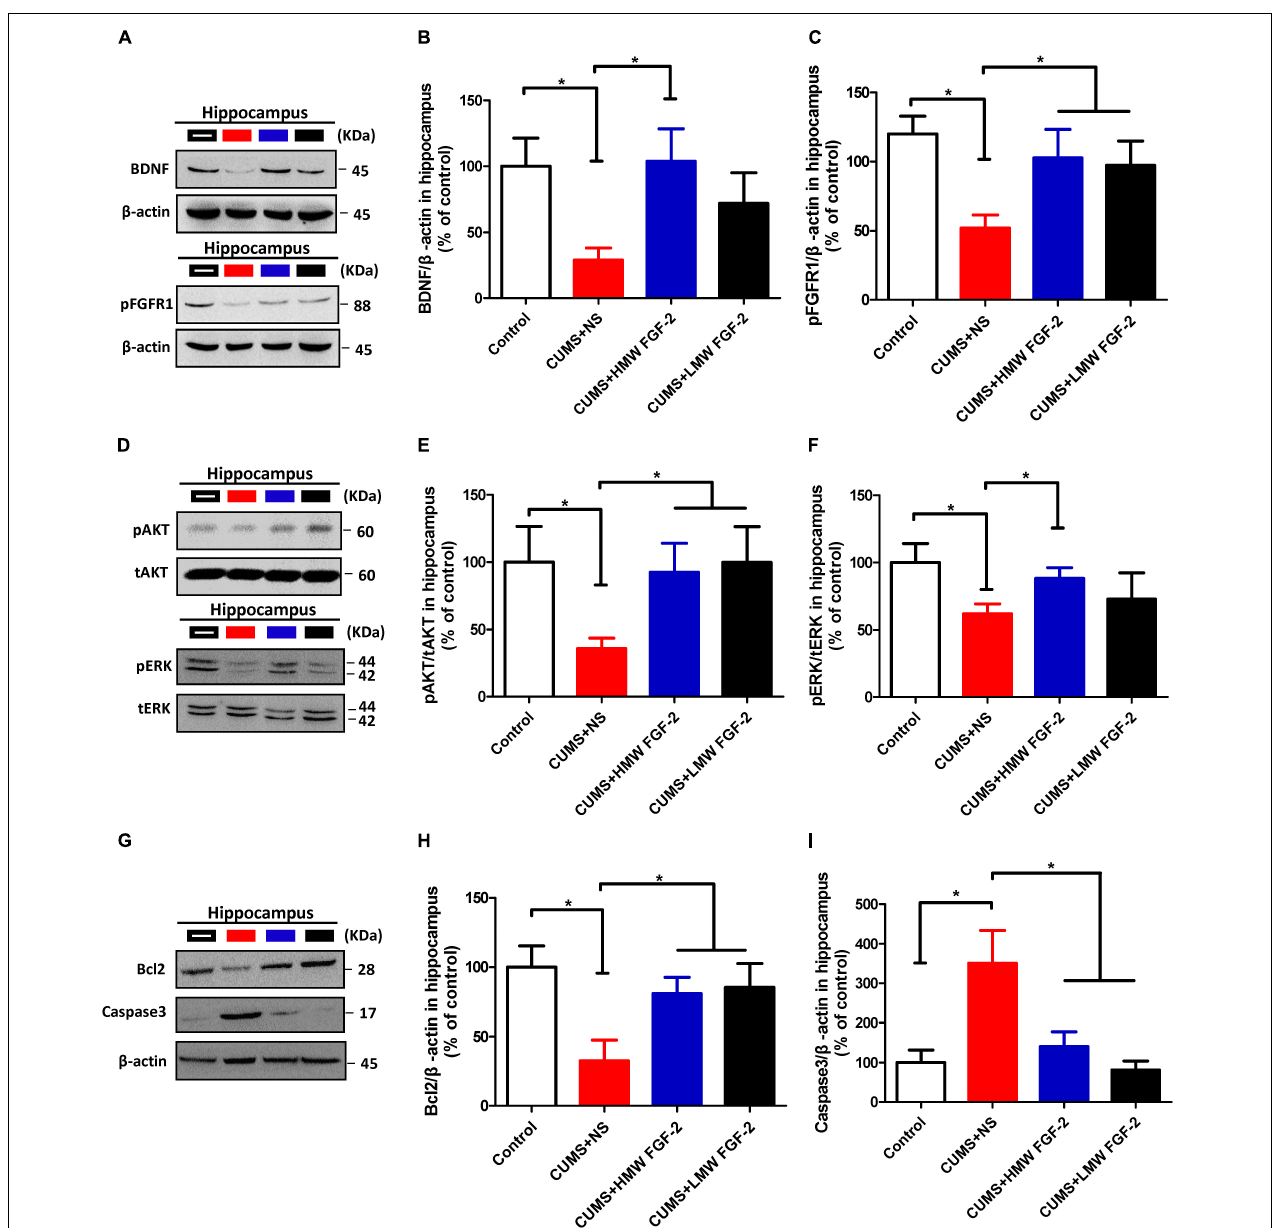
FIGURE 5 | FGF-2 upregulates BDNF protein expression and activates the ERK and AKT signaling pathways by acting on FGFR1 in the hippocampus of CUMS-induced mice. Representative immunoblots of BDNF and pFGFR1 (A) , p-AKT/t-AKT and p-ERK/t-ERK (D) , and Bcl-2 and caspase-3 (G) detected by Western blotting in hippocampal tissues. The remaining panels depict the quantification of immunoblotting bands of BDNF (B) , p-FGFR1 (C) , p-AKT (E) , p-ERK (F) , Bcl-2 (H) and caspase-3 (I) . Panels (B,C,E,F,H,I) were analyzed by one-way ANOVA with Tukey’s post hoc test, n = 5, ∗ p < 0.05, ∗∗ p < 0.01, and ∗∗∗ p < 0.001.